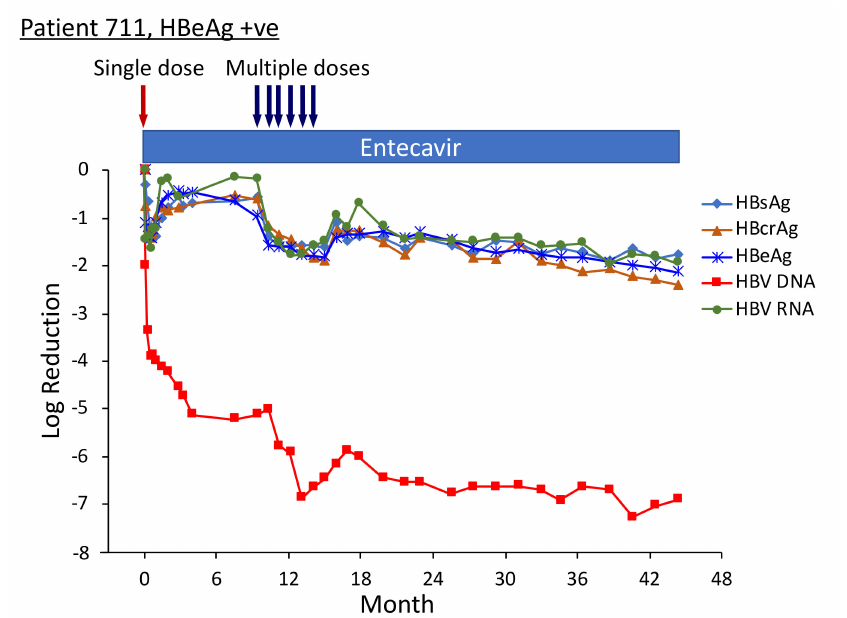
Figure 8. HBV parameters in HBeAg-positive patients treated with multiple doses of ARC-520. Previously NUC-naïve patients 708, 710 and 711 received daily NUC beginning on study Day 1, a single dose of ARC-520 on Day 1, and then multiple doses of ARC-520 (indicated with arrows) beginning approximately 7 months after the single dose of ARC-520. Log 10 reductions in HBsAg, HBcrAg, HBeAg, serum HBV DNA and serum HBV RNA are shown. Empty symbols indicate the analyte was not detected. Reproduced from [22] with permission from BMJ Publishing Group Ltd. of the British Medical Association, London,